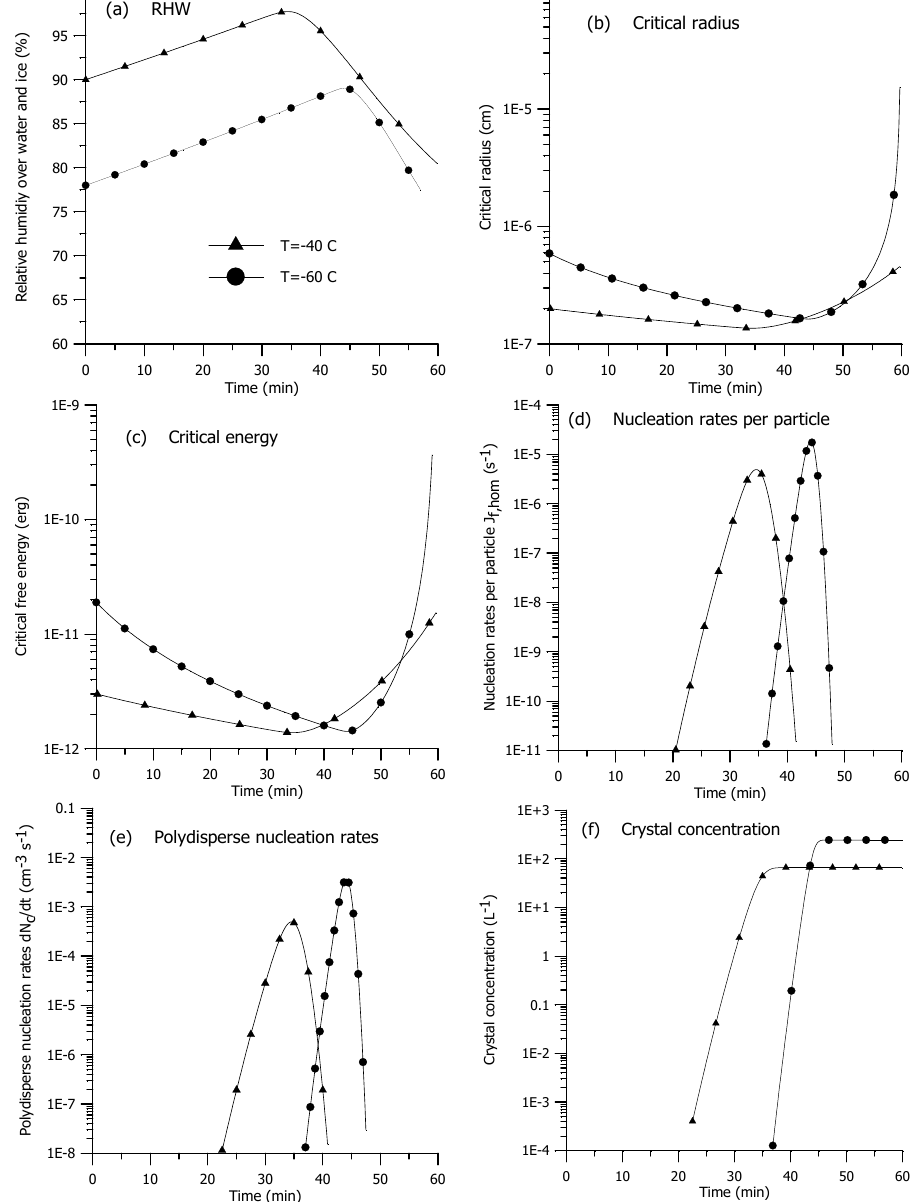
Fig. 5. Comparison of homogeneous nucleation kinetics at T = − 40 ◦ C and − 60 ◦ C. The other parameters are: RHW 0 ( − 40 ◦ C) = 90% and RHW 0 ( − 60 ◦ C) = 78%, p 0 = 340hPa, w = 4cms − 1 . (a) Relative humidity over water RHW; (b) critical radius r cr ; (c) critical free energy 1F cr ; (d) homogeneous J f , hom r 3 a nucleation rates for a particle with radius of 0.11 µm; (e) polydisperse nucleation rates, R f , hom = d N fr / d t , defined by Eq. (18d); (f) crystal